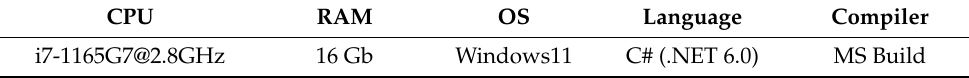
Table 2. The required personal computer specifications and environment used to drive the TSPDA.